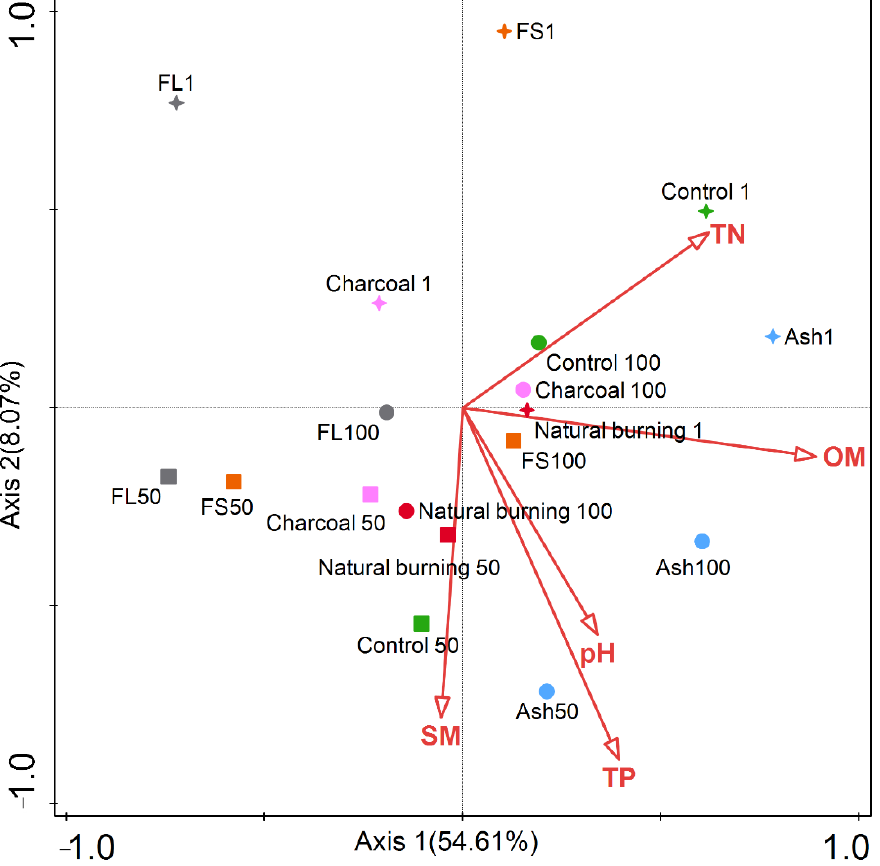
Figure 7. Constrained ordination diagram for samples in the first two redundancy analysis axes based on the soil physicochemical characteristics of the different treatments and their interrelationships with the structure of the soil nematode-trapping fungi (NTF) communities. FS: treated with flame gun and the burn duration was 20 min; FL: treated with flame gun and the burn duration was 60 min; Charcoal: treated with Charcoal; Ash: treated with cooled ash; Natural burning: treated with dry pine needles placed directly on the soil and let burn naturally and ashes were left on the soil after burn; Control: without any treatment. Numbers behind the group name shown the detection time point. 1: The 1th day; 50: The 50th day; 100: The 100th day.